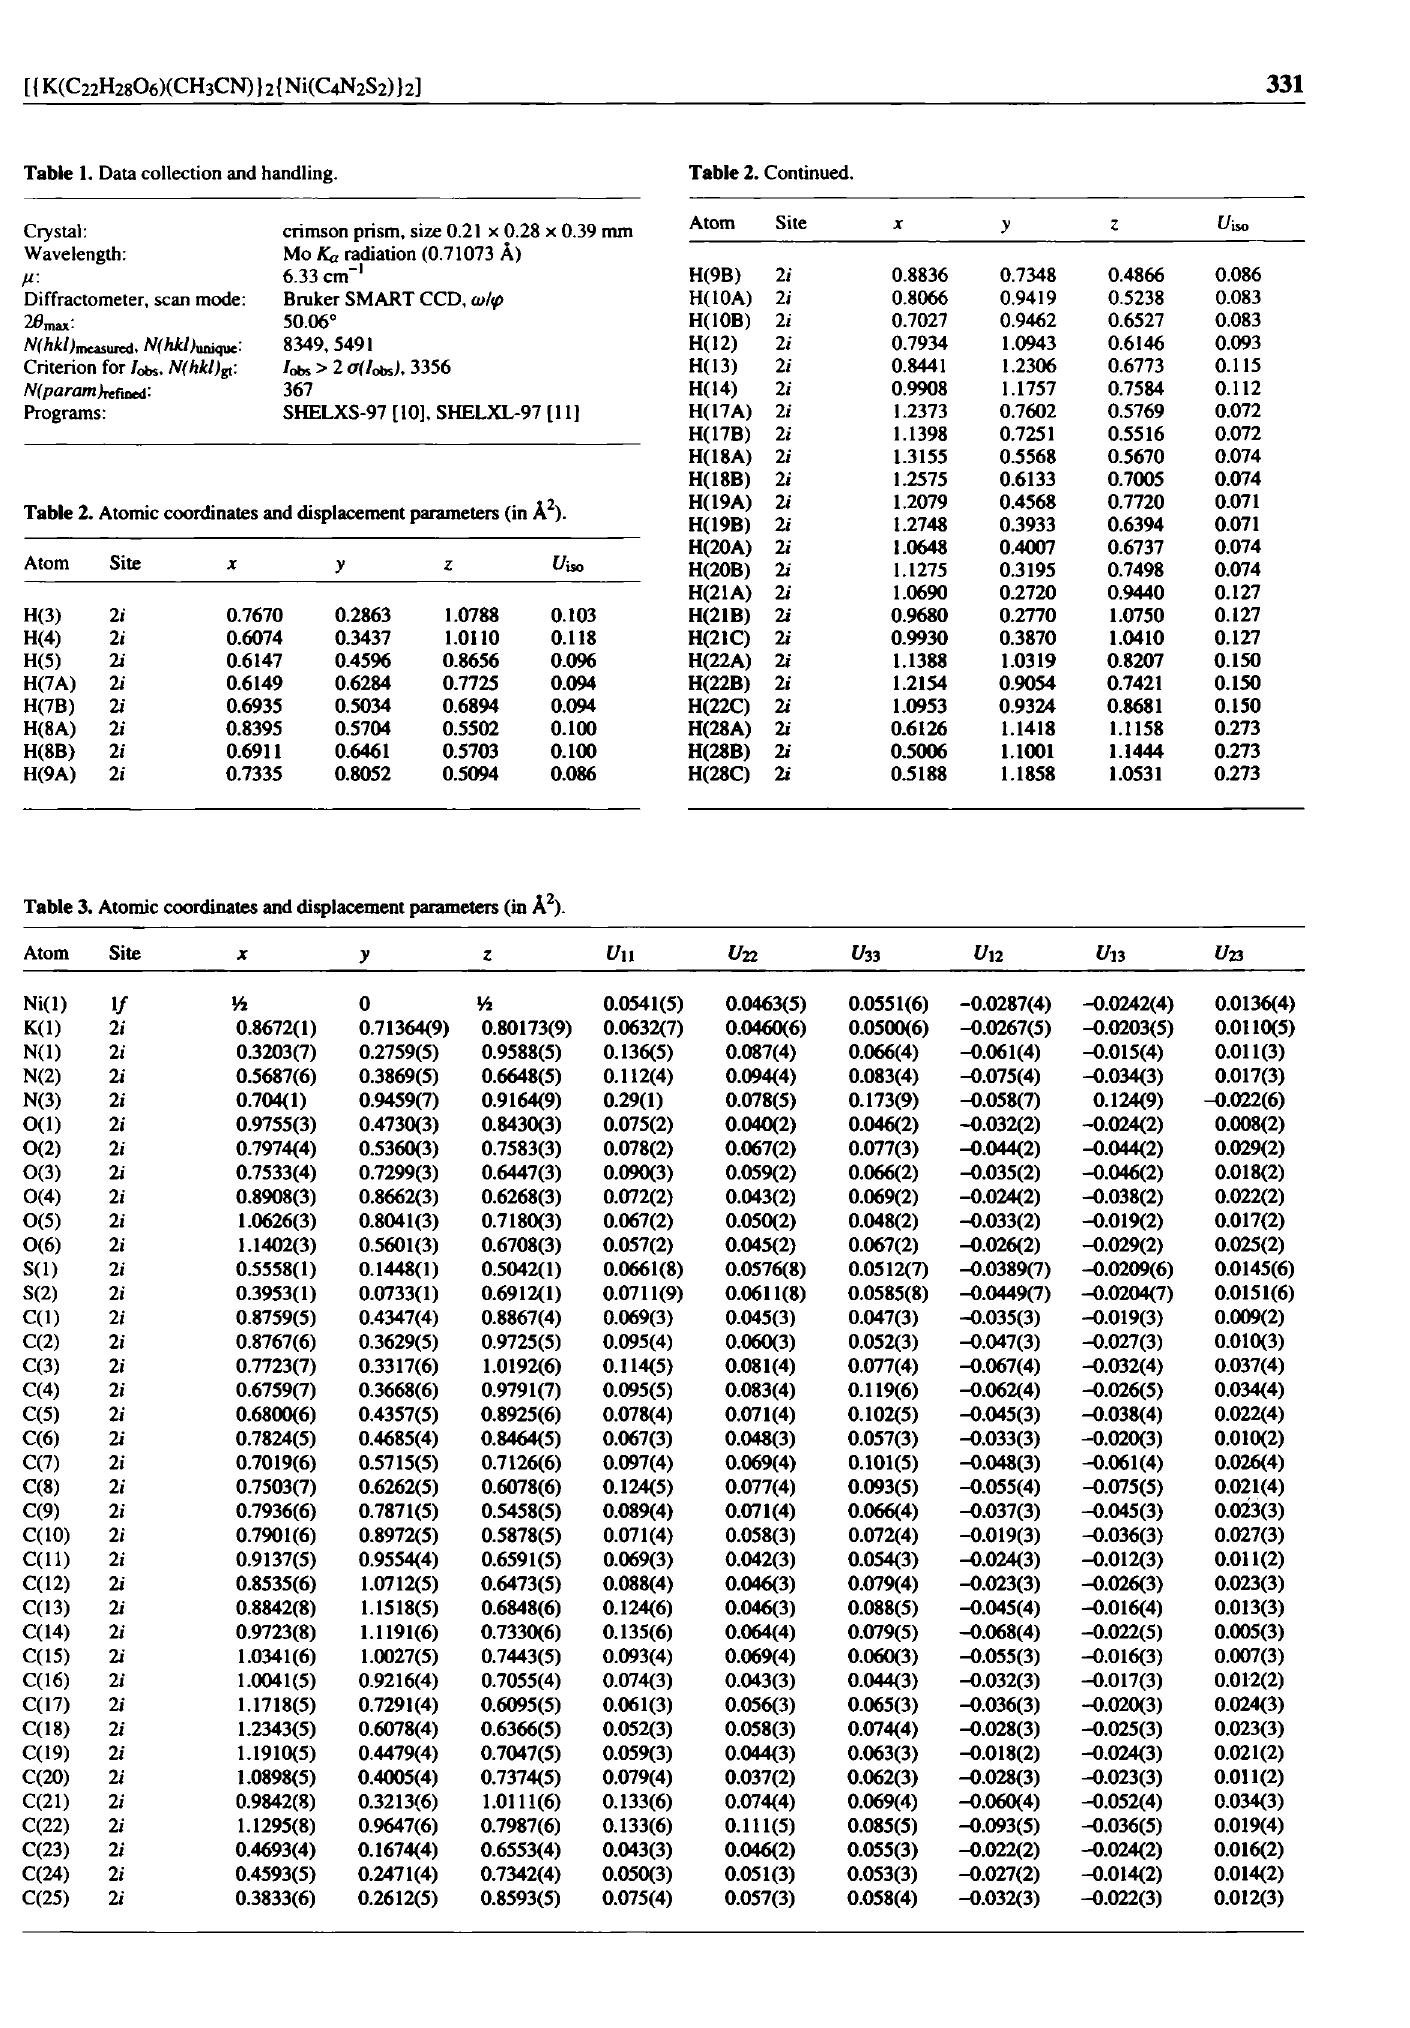
Table 2. Atomic coordinates and displacement parameters (in A 2 ).